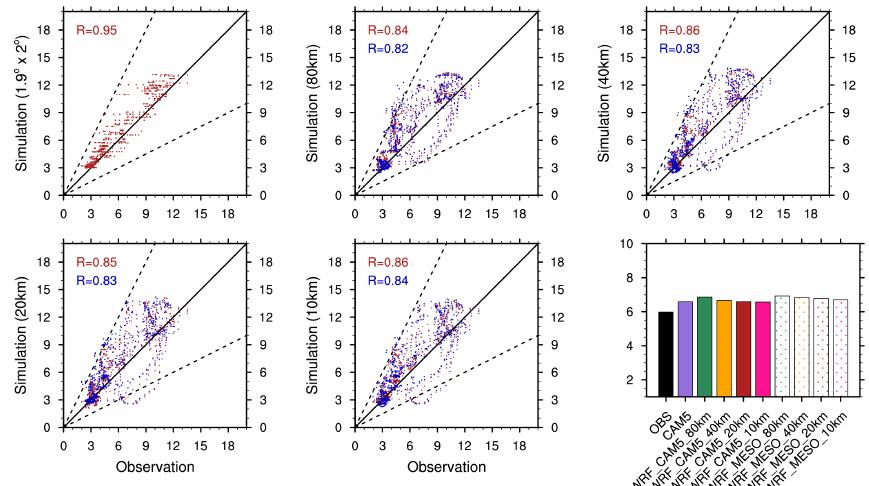
Fig. 13. Scatterplots of total column precipitable water vapor (gm − 2 ) from model simulations that utilize the CAM5 (red) and WRF (blue) physics suite evaluated against the ARM best estimates at Barrow.